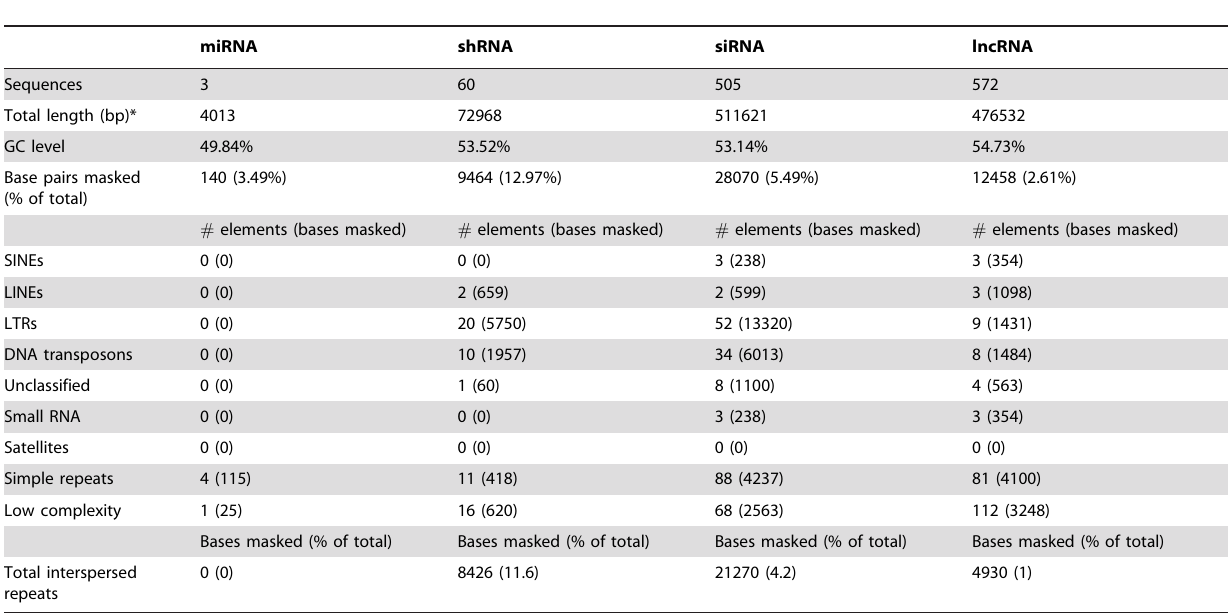
Table 5. Repetitive element content of genic lncRNA candidates by